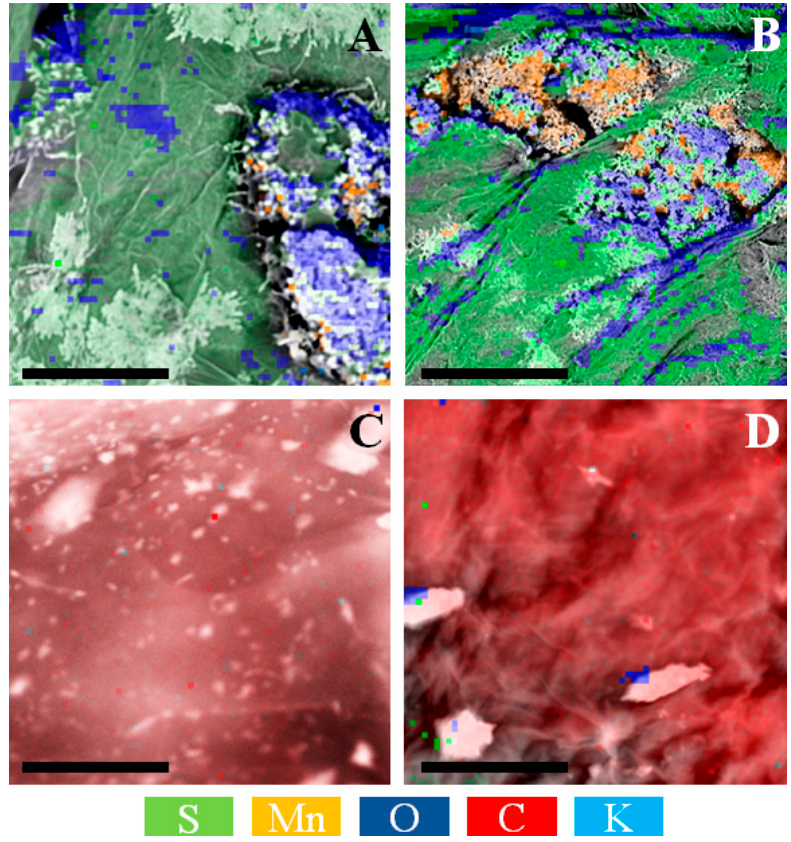
Figure 6. EDS maps of: ( A ) as-obtained, ( B ) aged as-obtained, ( C ) purified, ( D ) aged purified samples. The scalebar is 200 μ m. Table 1. Percentage of elements in the material.